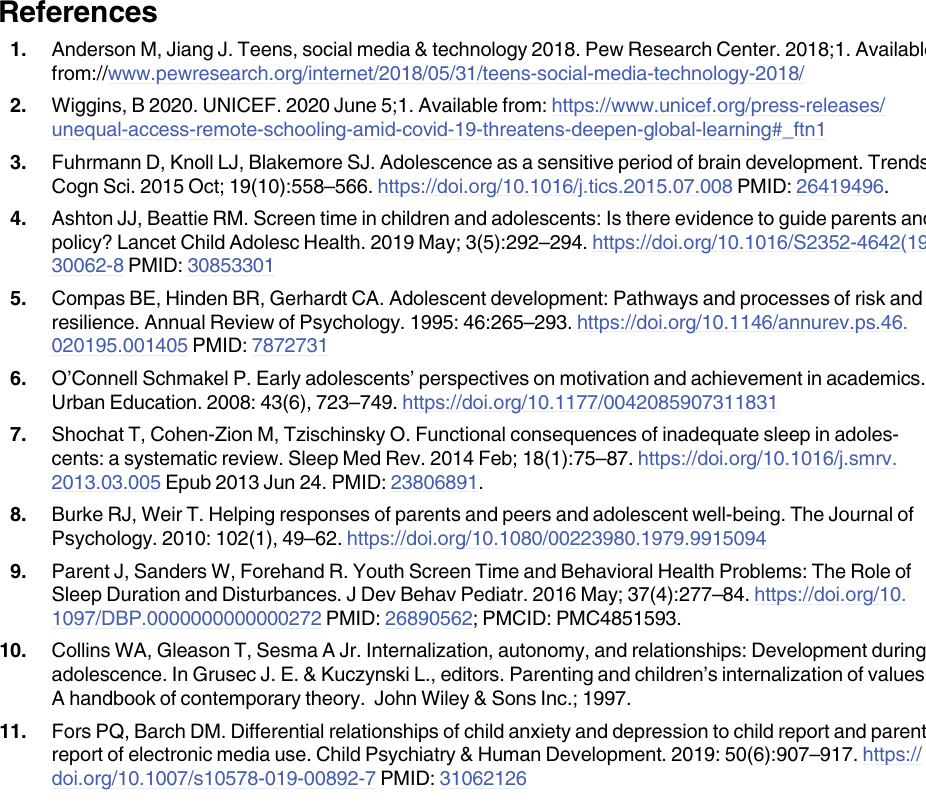
S31 Table. Number of close friends who are girls regressed on various types of weekend screen time for Part 2, controlling for SES and race/ethnicity, separated by sex. Note . Starred regressions are significant at alpha